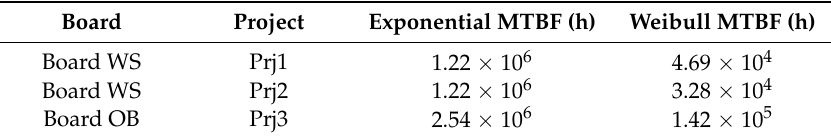
Table 3. Exponential vs. Weibull MTBF (Mean Time Between